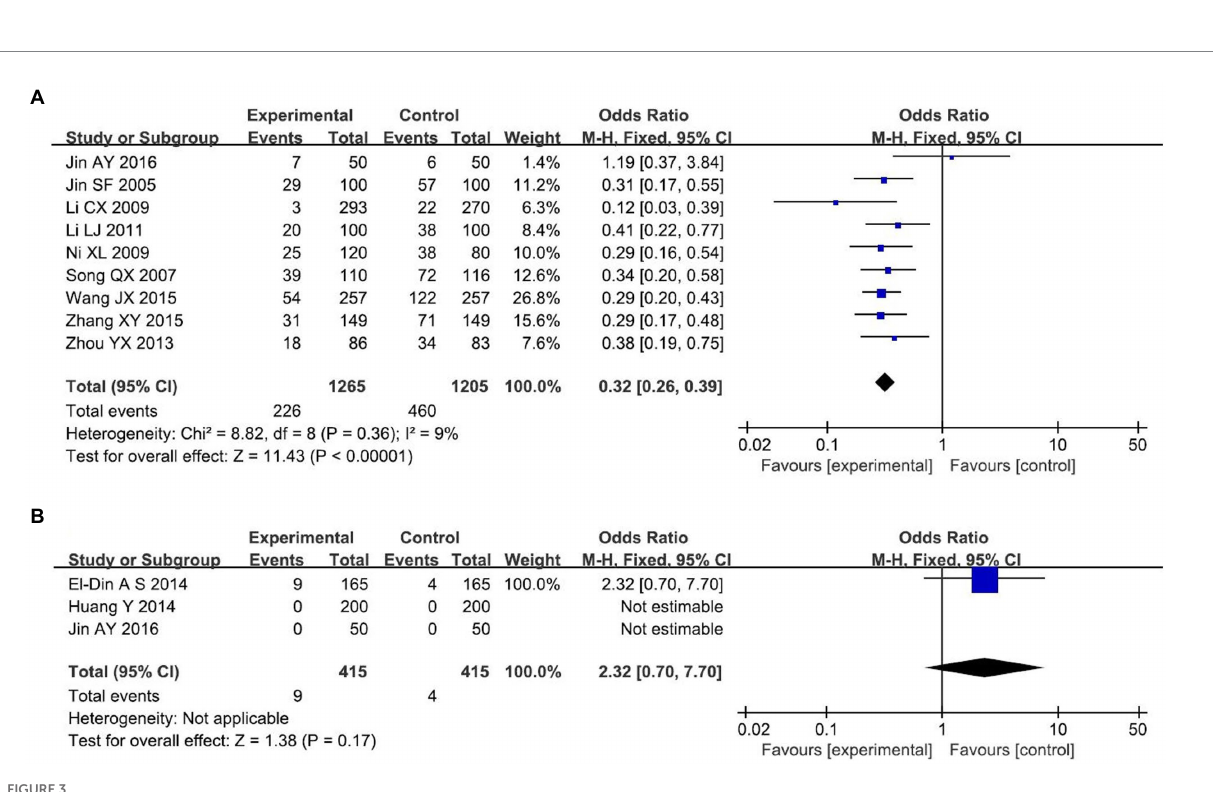
FIGURE 3 Perineal laceration (A) Laceration rate. (B) Severe laceration